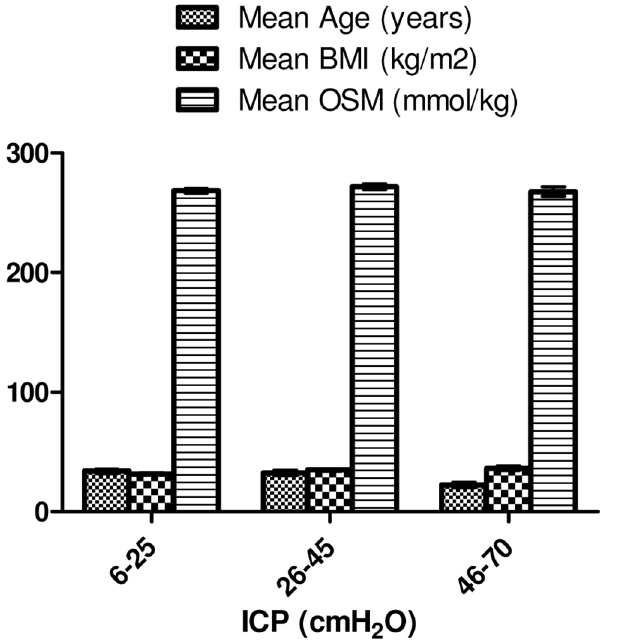
Fig 3. ICP Groups. All 66 participants, 90 samples. Error bars based on SE.